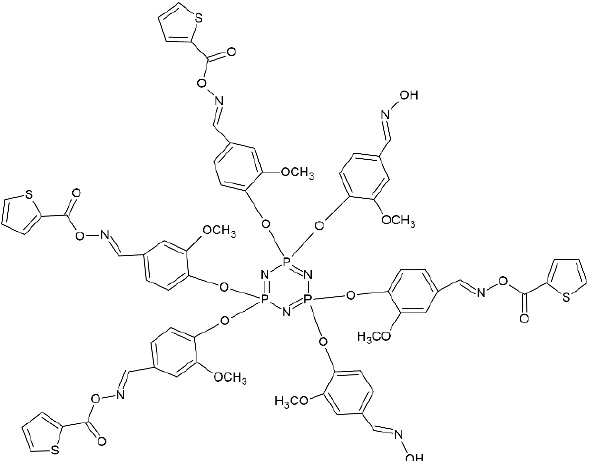
Figure 10. The oxime cyclotriphosphazene derivative exhibiting antimicrobial activity comparable to Ciprofloxacin and Fluconazole.